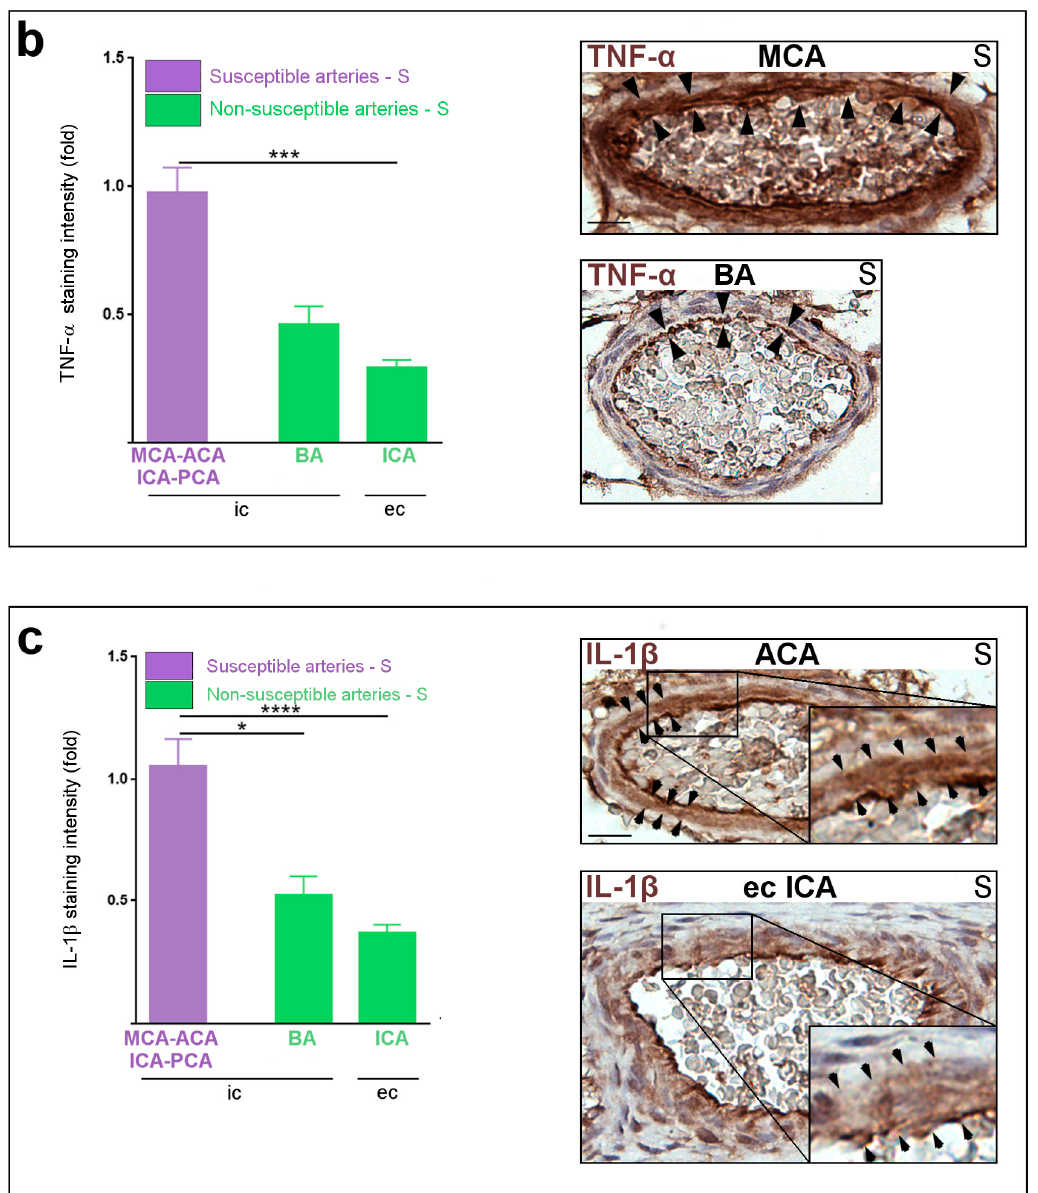
Figure 1. Macrophagic infiltration and pro-inflammatory cytokines expression within the arterial wall of PAIS-susceptible vs. non-susceptible artery of P1 pups from the S group: ( a , left panel) Increased density of Iba-1+ cells in PAIS-susceptible vs. non-susceptible arteries; ( a , right panels) Iba-1+ cells (black arrowhead) in a susceptible intra-cranial artery (icICA) vs. non-susceptible extra-cranial artery (ecICA) to PAIS; ( b , left panel) increased expression of TNF- α in PAIS-susceptible vs. non-susceptible arteries; ( b , right panels) increased TNF- α staining (black arrowheads) in PAIS-susceptible (MCA) vs. non-susceptible (BCA) arteries; ( c , left panel) increased expression of IL-1 β in PAIS-susceptible vs. non-susceptible arteries; and ( c , right panels) increased IL-1 β staining (black arrowheads) in PAIS-susceptible (ACA) vs. non-susceptible (ecICA) arteries. Data are presented as mean ± standard error of the mean (SEM). * p < 0.05, *** p < 0.001, **** p < 0.0001, Kruskal–Wallis test. Number ( n ) = 5–14 arteries from 5–7 animals per condition. Scale bar = 15 µ m. Abbreviations: ACA, anterior cerebral artery; BA, basilar artery; ec, extra-cranial; Iba-1, Ionized calcium binding adapter molecule-1; ic, intra-cranial; ICA, internal carotid artery; IL-1 β , Interleukin-1 β ; MCA, middle cerebral artery; PCA, posterior cerebral artery; S, saline; TNF- α , tumor necrosis factor- α .